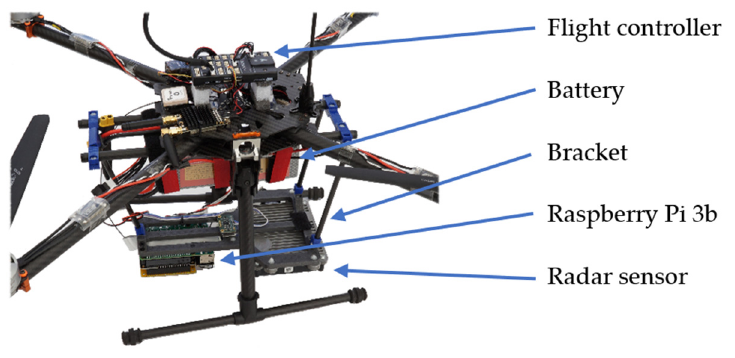
Figure 1. UAV based on Tarot Iron Man FY650 with flight controller Pixhawk 4, the battery and the complete measurement system.